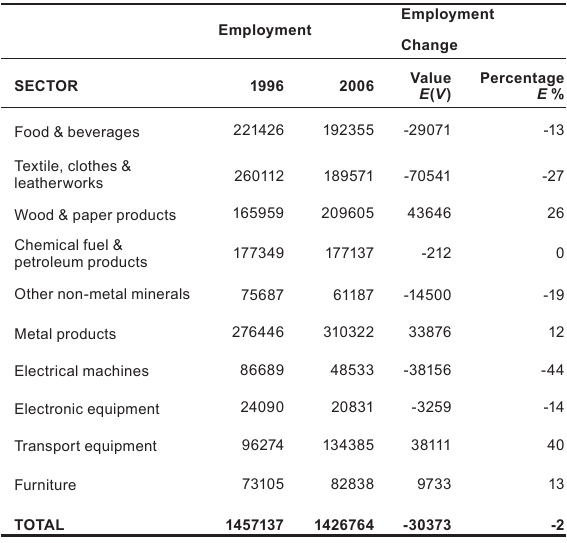
Table 1 Changes in national employment in South